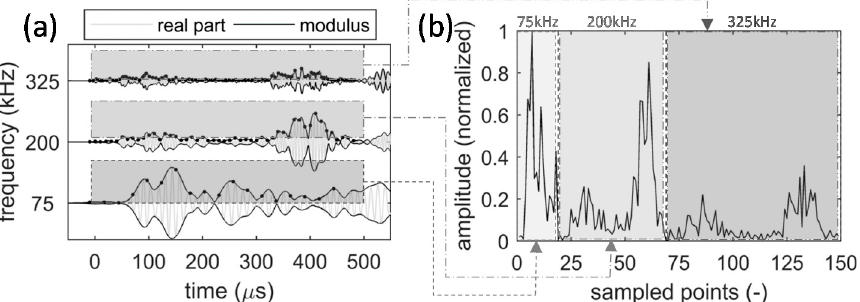
Figure 4. Across-frequency resampling of the modulus of the wavelet coefficients at 75 kHz, 200 kHz, and 325 kHz: ( a ) the real part and modulus of the wavelet coefficients for an AE waveform (resampling is indicated with dots); ( b ) the multi-frequency representation of the AE waveform.